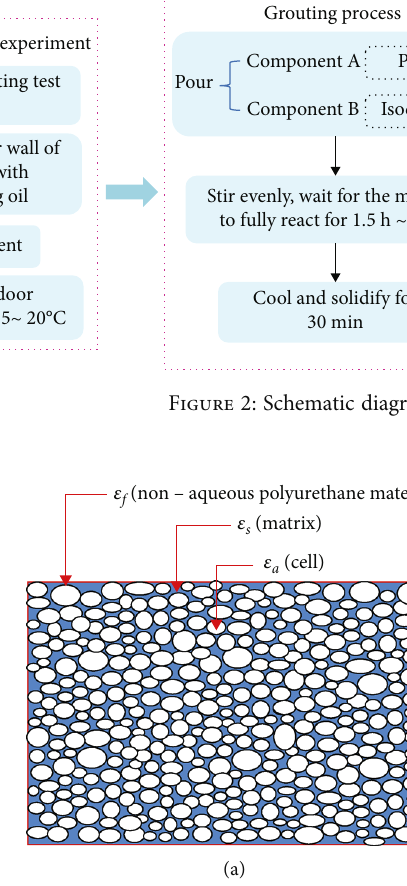
Figure 3: Microphysical model:.(a) Physical model diagram of 0.11 g/cm 3 . (b) Physical model diagram of 0.40g/cm 3 .